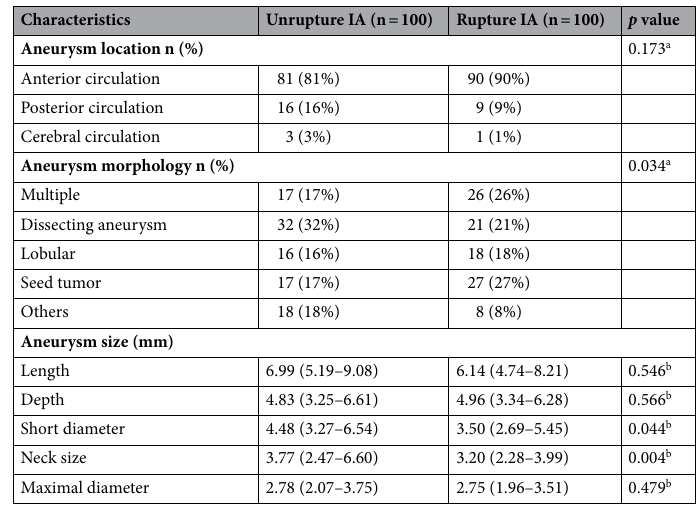
Table 3. Intracranial aneurysm characteristics. IA, intracranial aneurysm. Data are presented as the number and percentage (%), and median with interquartile interval [Q1–Q3]. a, Chi-square test; b, Mann–Whitney test. p < 0.05 was considered to suggest a significant